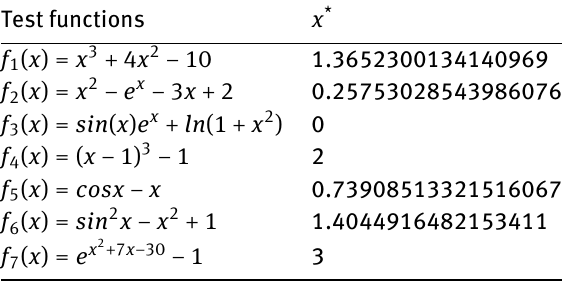
Table 1: Test functions and display the computed approximate zero x *